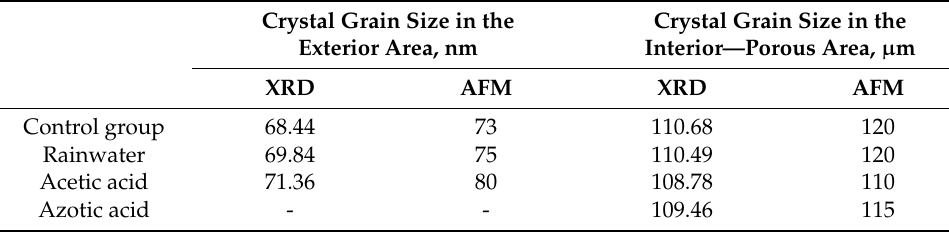
Table 5. Crystal grain average diameter determined by XRD (Scherrer) and AFM. Crystal Grain Size in the Exterior Area,